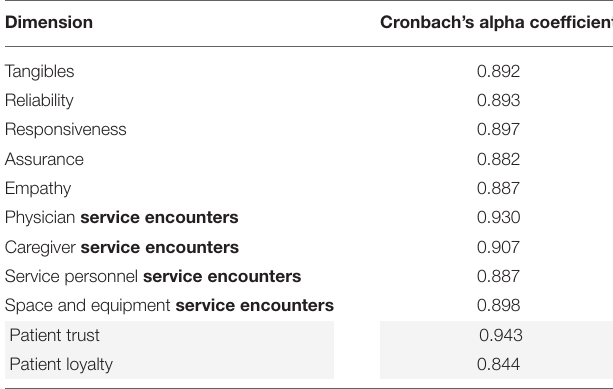
TABLE 2 | Reliability analysis ( n = 483).